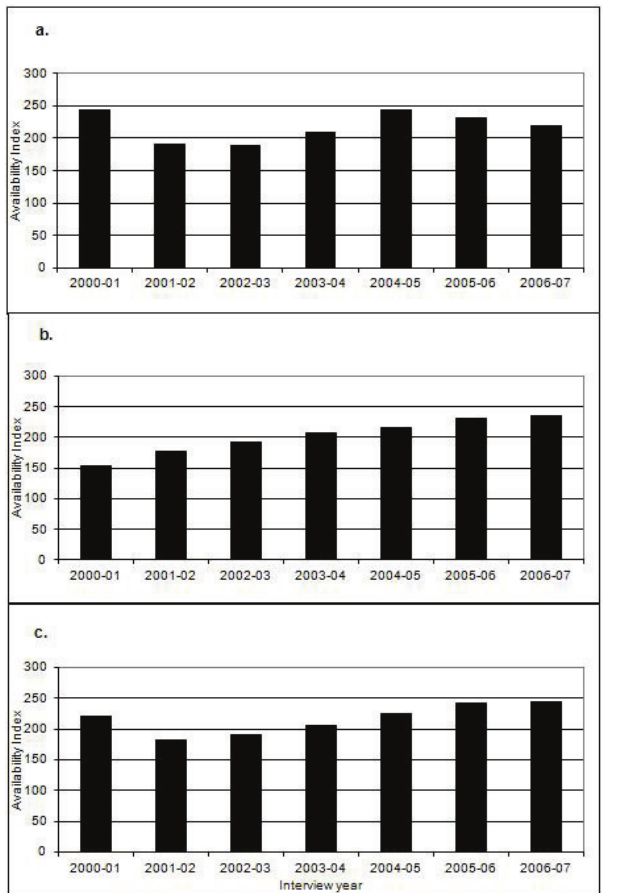
Fig. 1. Annual (2000–2007) fall (a), winter (b), and spring (c) availability index values of the Porcupine cari- bou herd based on community interviews.